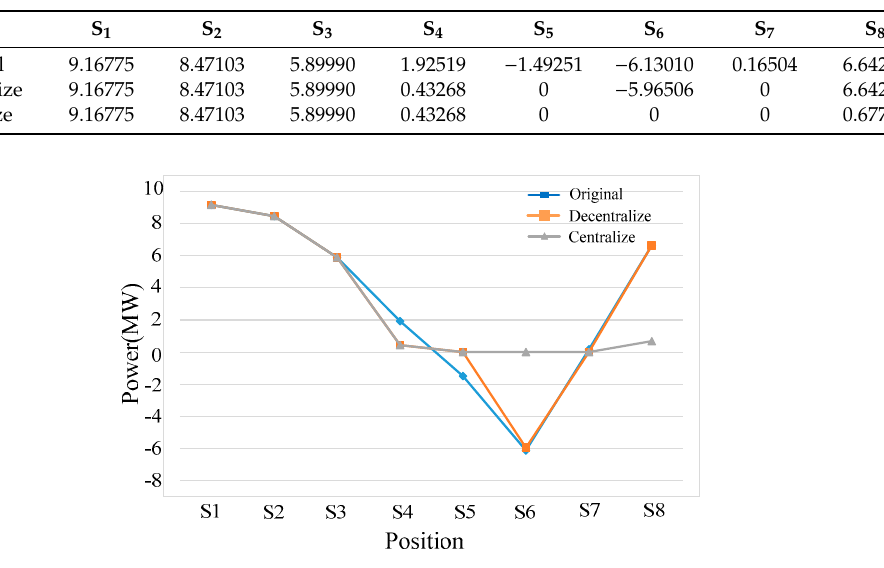
Figure 24. Results before and after control in case 3.